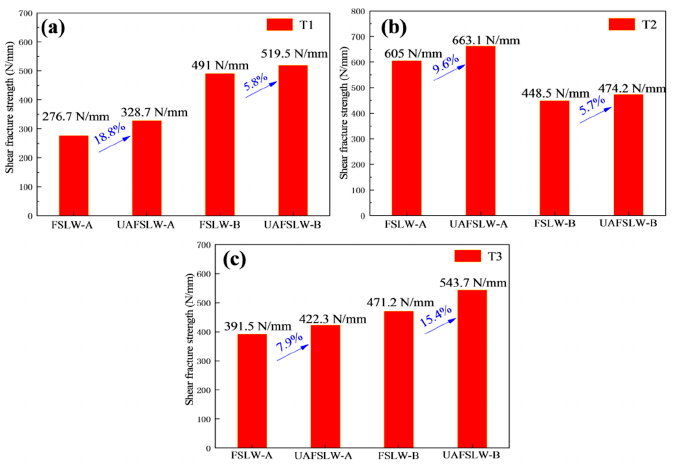
Figure 11. Shear fracture strength of FSLW and UAFSLW joints that were welded using ( a ) tool T1, ( b ) tool T2, and ( c ) tool